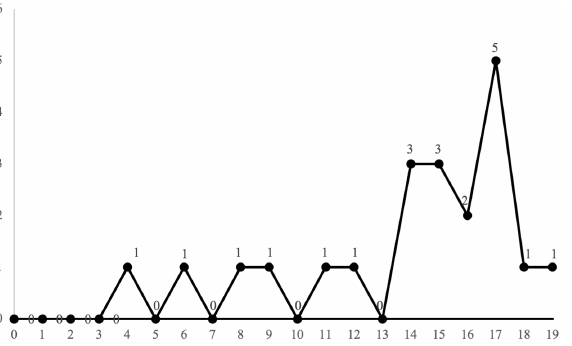
Figure 2. Number of articles published per year (1999–2019).